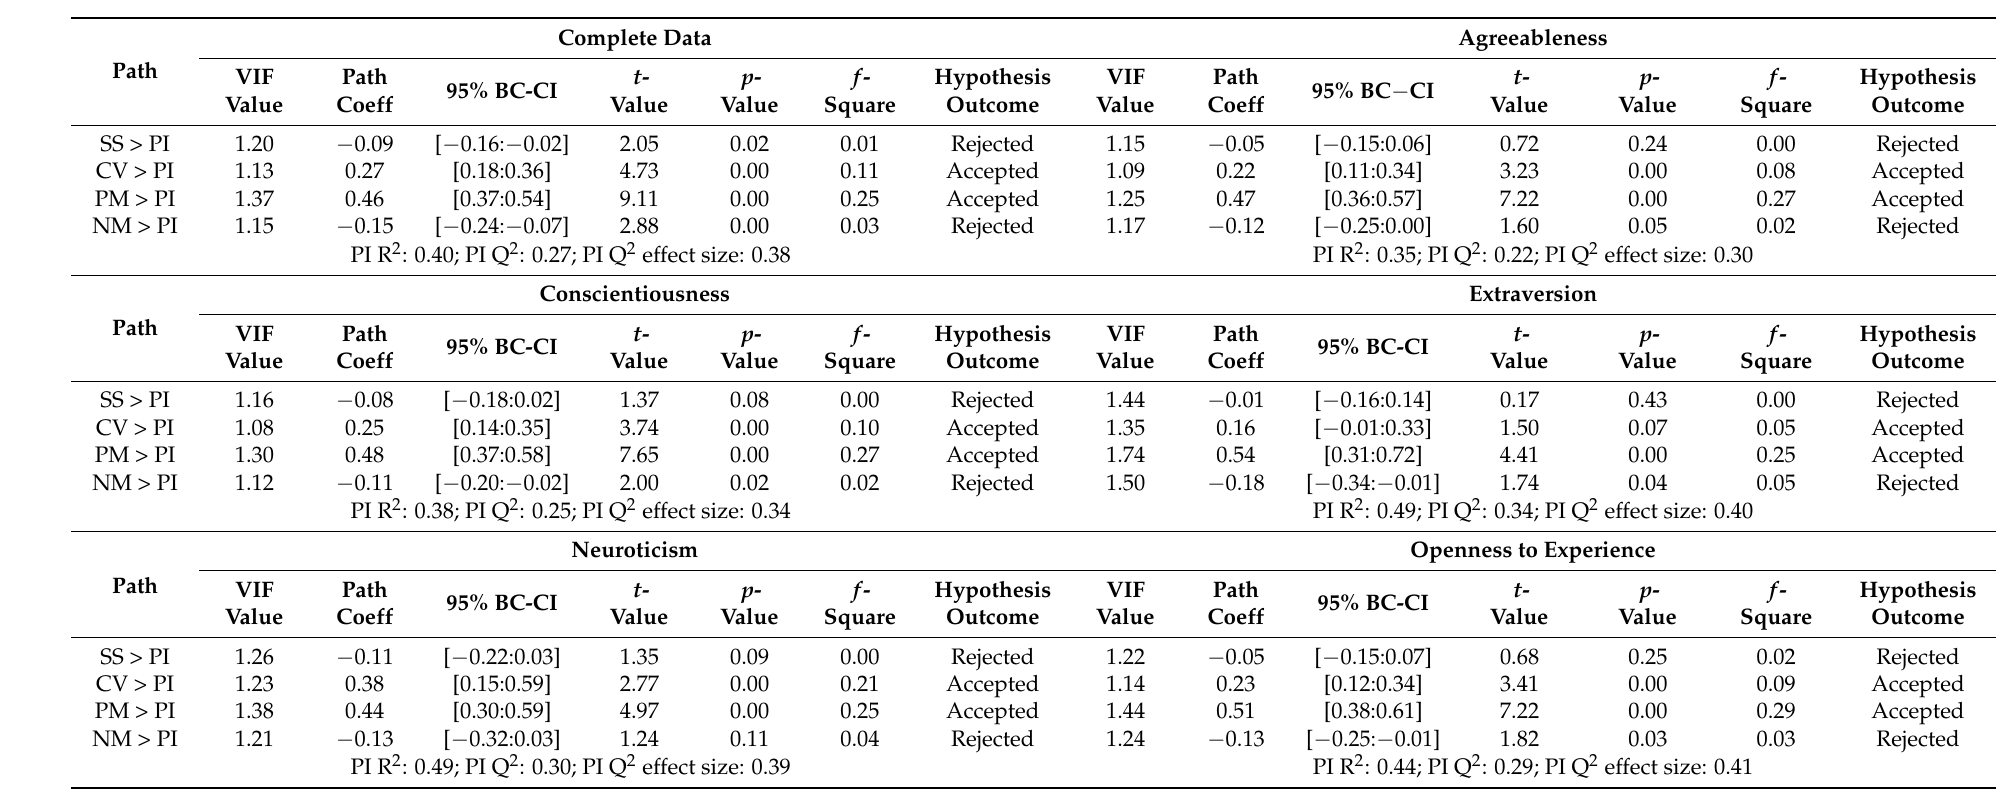
Table 4. Results of the structural